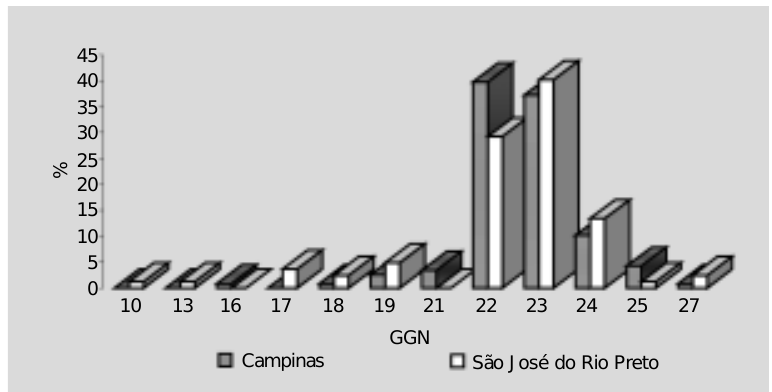
Figure 1. Distribution of CAG repeats among individuals from Campinas and São José do Rio